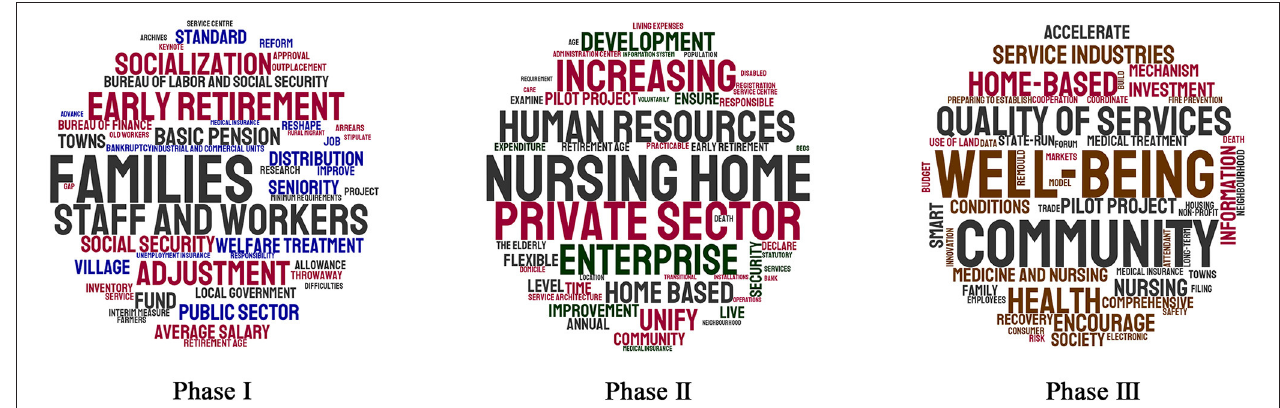
FIGURE 4 | Keywords tag cloud of China’s local elderly care policy based on TF-IDF.